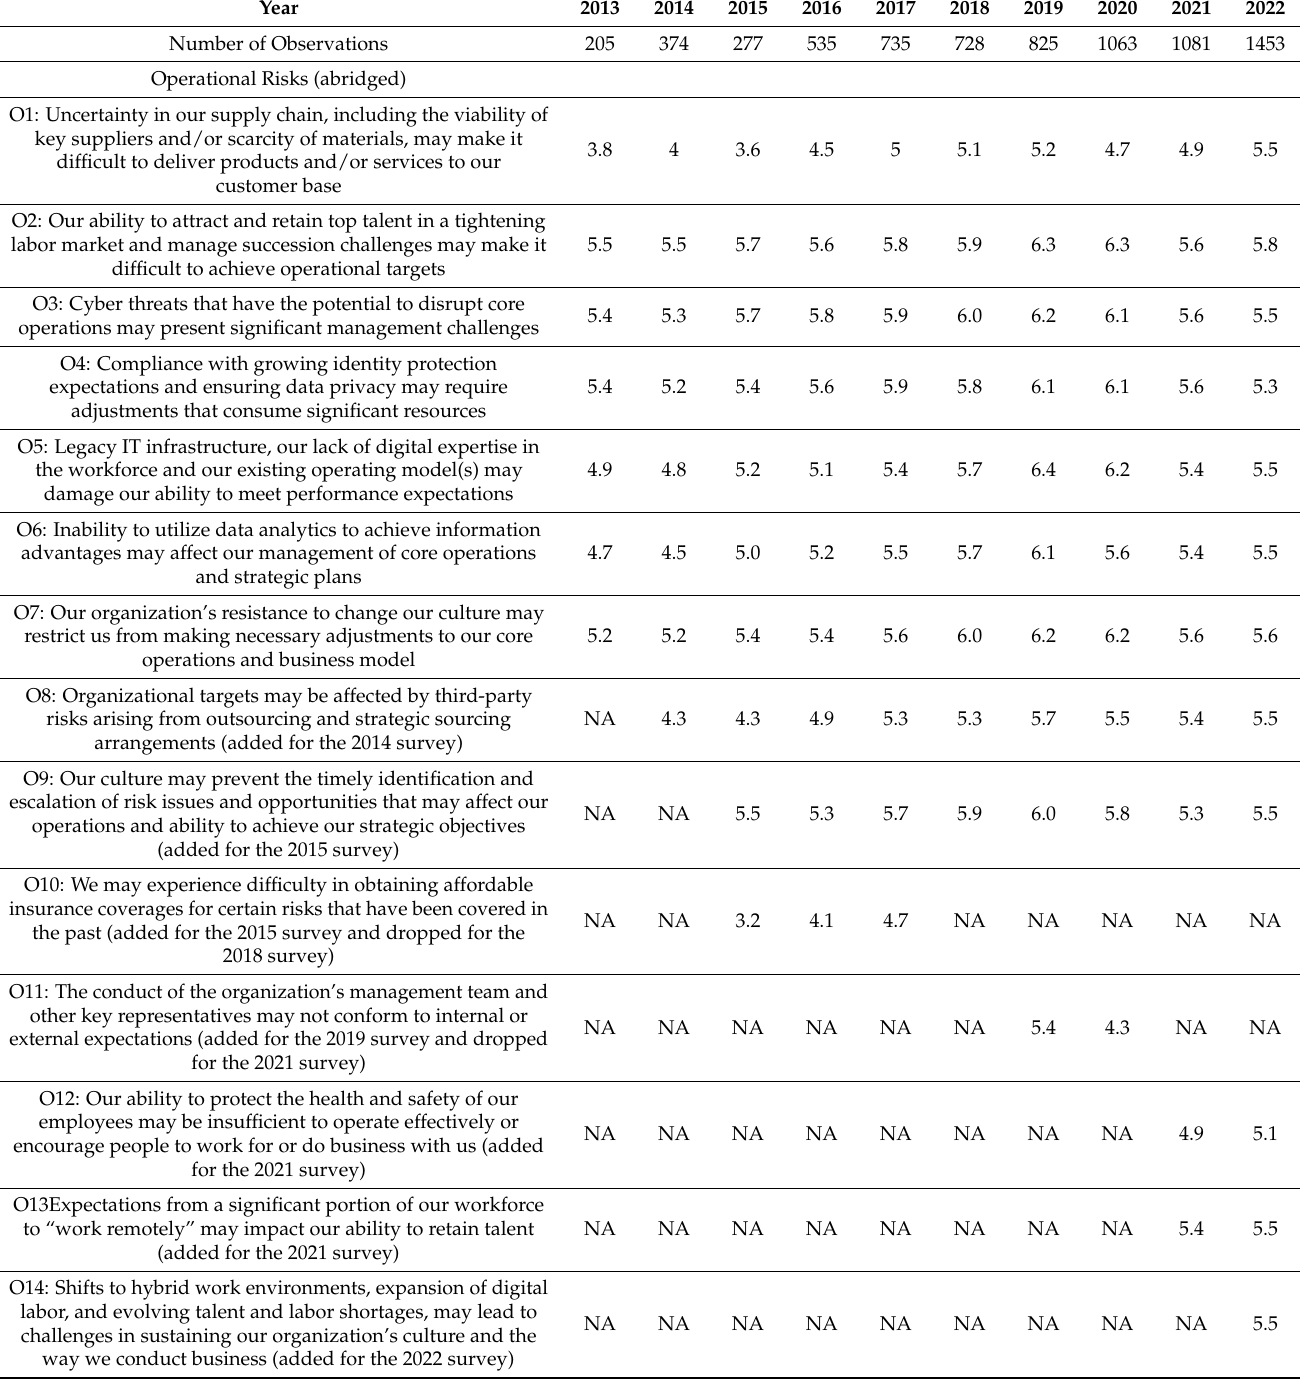
Table 8. Survey Responses for Operational Risk